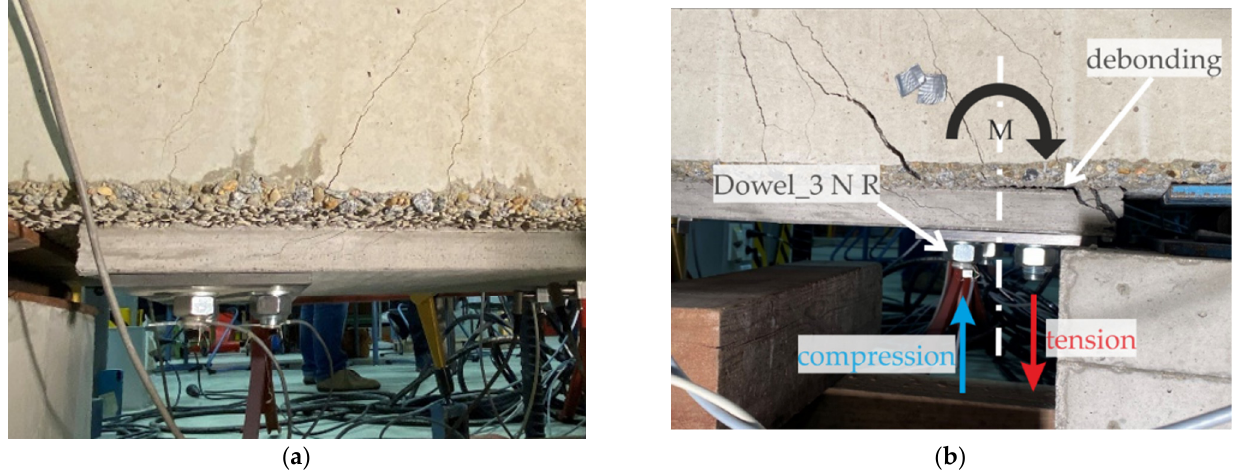
Figure 23. Anchored ends of the strengthening layer at the moment of failure of the right side: ( a ) left side; ( b ) right side. (Photos: CARBOCON GMBH).